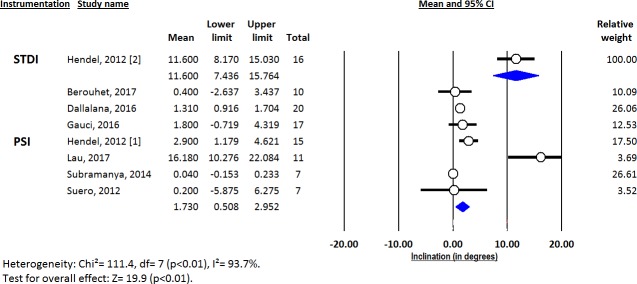
Forest plot of inclination deviation from the pre-operative planning, for clinical studies.